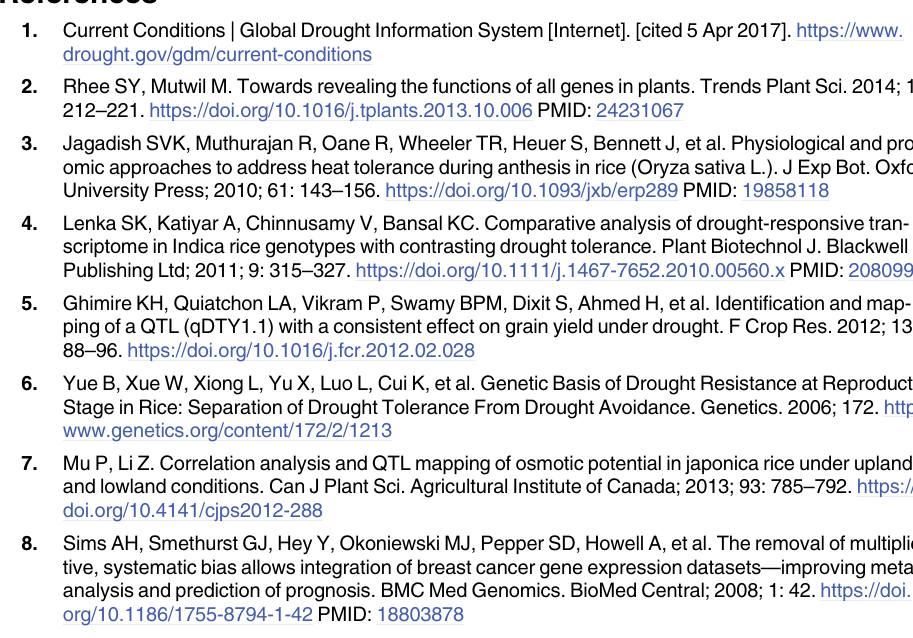
S9 Table. Distribution of DEGs from up and down-regulated drought-responsive modules in the 6 microarray studies across 9 data subsets. S10 Table. Distribution of the DEGs (after screening for important genes) used for the construction of uDTN and dDTN shown across 9 data subsets. S11 Table. Distribution of uDTN and dDTN DEGs shown across 9 data subsets (after extracting PPIs). S12 Table. Distribution of DEGs in uDTN clusters. S13 Table. Distribution of DEGs in dDTN